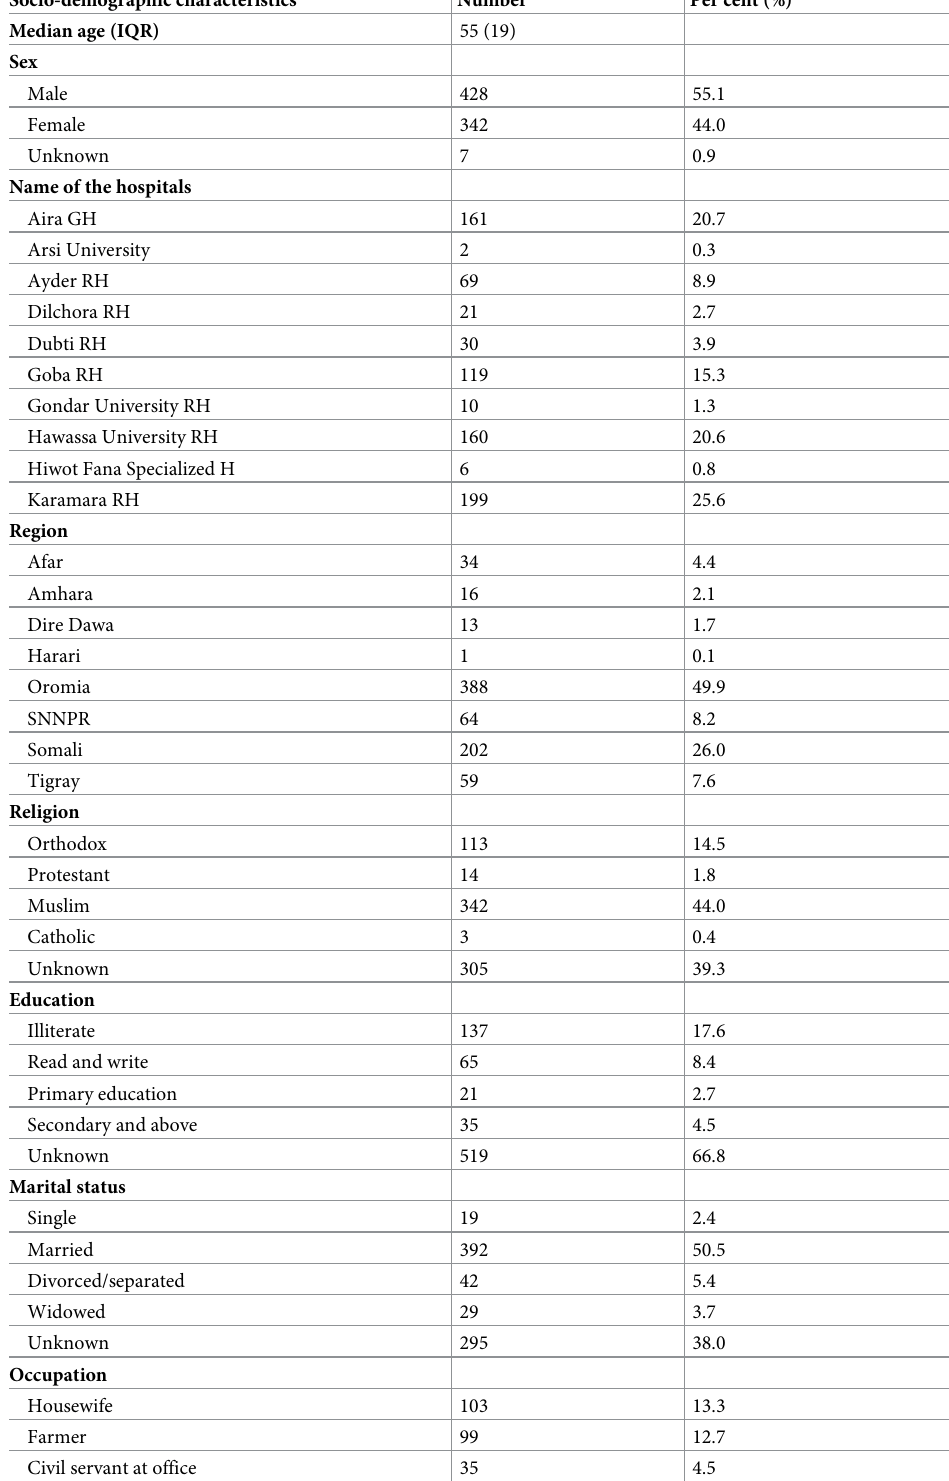
Table 1. Socio-demographic characteristics of oesophageal cancer patients in selected hospitals, Ethiopia,